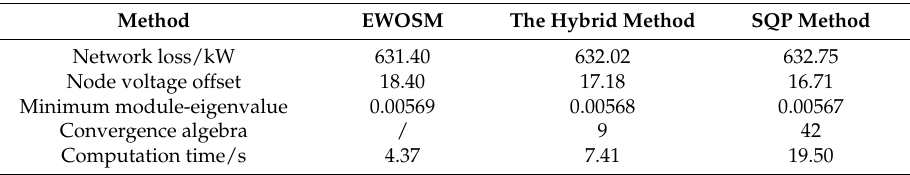
Table 7. Comparison of computation time and results with three